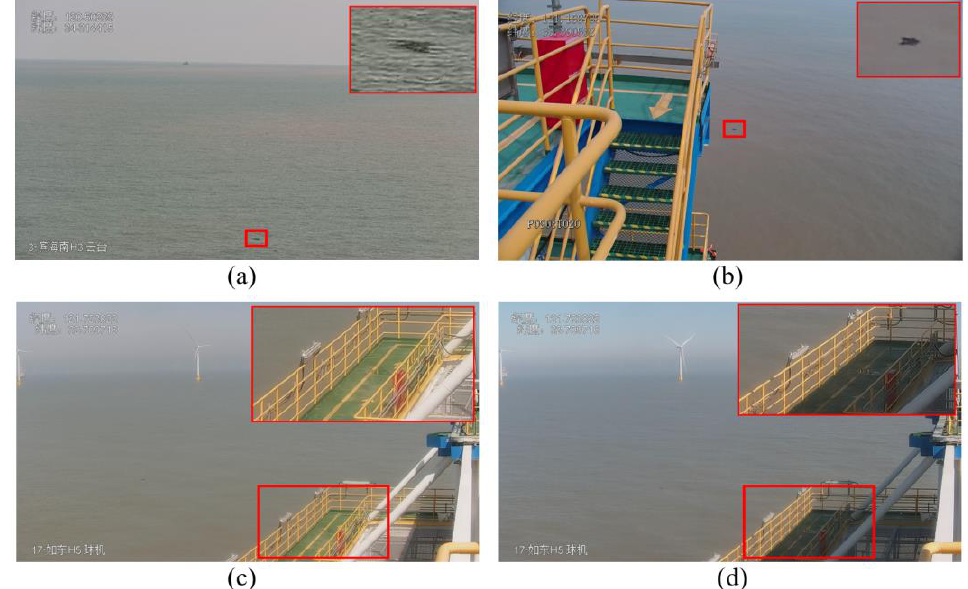
Figure 2. The environmental variety for the floating-algae detection task. ( a , b ) show the floating algae in windy weather and calm weather, respectively. ( c , d ) show the detection conditions in sunny weather and cloudy weather,